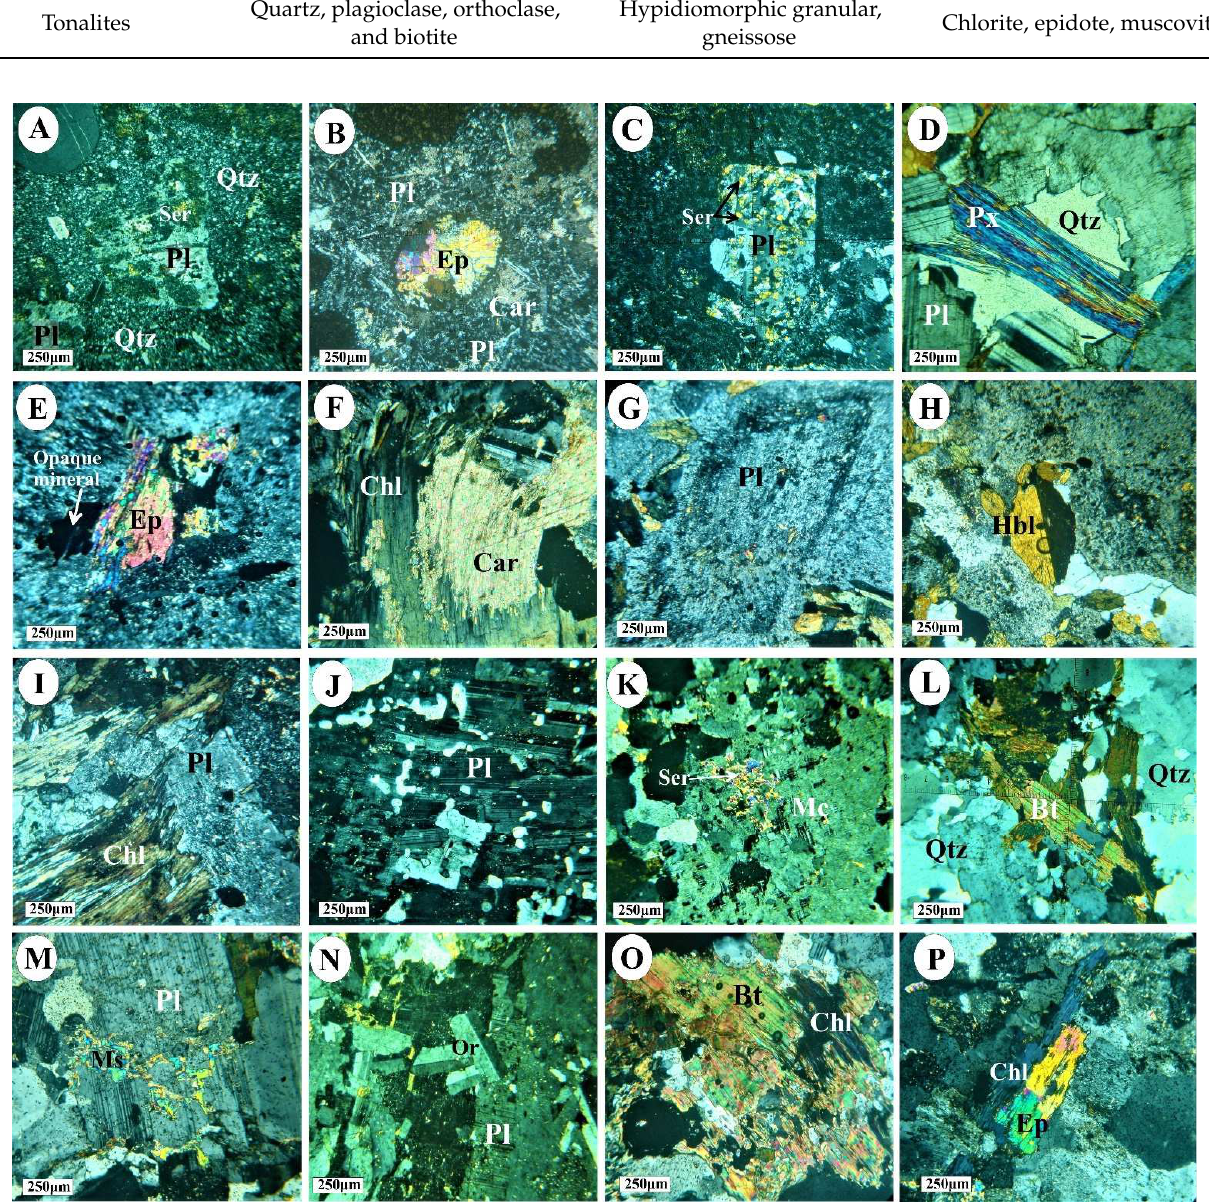
Figure 4. Photomicrographs showing some petrographic characteristics of Abu–Ghalaga under cross-polarized light (XPL): metarhyolite ( A ), metabasalt ( B ), metaandesite ( C ), metagabbro ( C – F ), quartz diorite ( G – I ), biotite granodiorite ( J – L ), and tonalite rocks ( M – P ). ( A ) Porphyritic texture showing phenocryst of plagioclase (Pl) crystals within fine grains of quartz (Qtz). ( B ) Epidote (Ep) secondary mineral filling the vesicular texture. ( C ) Plagioclase altered (Pl) to saussuritization. ( D ) Schiller structure-associated subophitic texture. ( E ) Pyroxene (Px) altered to epidote (Ep). ( F ) Two stages of alteration: chloritization is formed as an alteration product of clinopyroxene, and carboni- zation mostly appears as large, stained, grained aggregates replacing chlorite (Chl). ( G ) Grains of sericitized plagioclase with fresh rims. ( H ) Baveno twinning of hornblende (Hbl). ( I ) Chlorite (Chl) after hornblende (Hbl) surrounding plagioclase (Pl). ( J ) Poikilitic and graphic textures. ( K ) Micro- cline (Mc) grain showing sericitized core. ( L ) Large biotite crystals (Bt). ( M ) Muscovite (Ms) after plagioclase (Pl). ( N ) Orthoclase (Or) crystals associated with plagioclase (Pl). ( O ) Violet irregular chlorite particles (Chl) after biotite (Bt). ( P ) Berlin blue interference color of chlorite (Chl) and well- developed epidote crystals (Ep). The metagabbros are composed essentially of deformed clinopyroxene, plagioclase, and hornblende. Epidote, chlorite, and carbonate are the main secondary minerals, whereas quartz is less common. Opaque minerals occur in a high ratio in this rock as